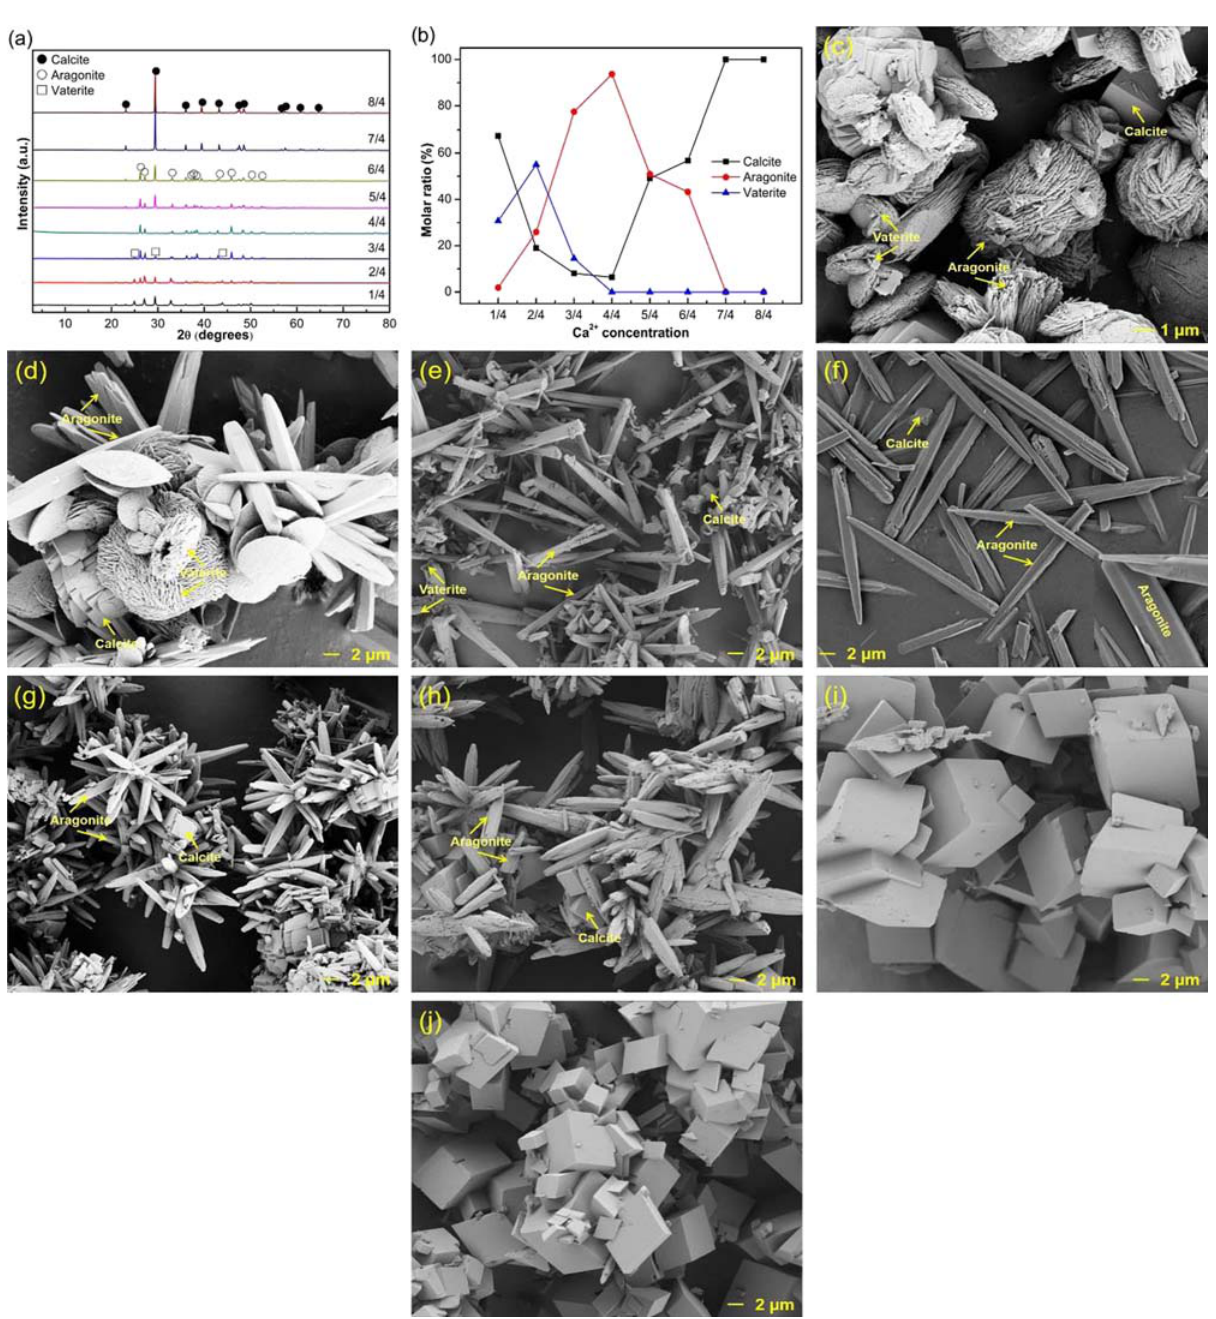
Figure 3: E ff ect of Ca 2 + concentration on crystal phase and morphology: ( a ) XRD patterns of the product, ( b ) composition of the products calcite, aragonite, and vaterite, and SEM images of the product at ( c ) 1 / 4, ( d ) 2 / 4, ( e ) 3 / 4, ( f ) 4 / 4, ( g ) 5 / 4, ( h ) 6 / 4, ( i ) 7 / 4, and ( j ) 8 /